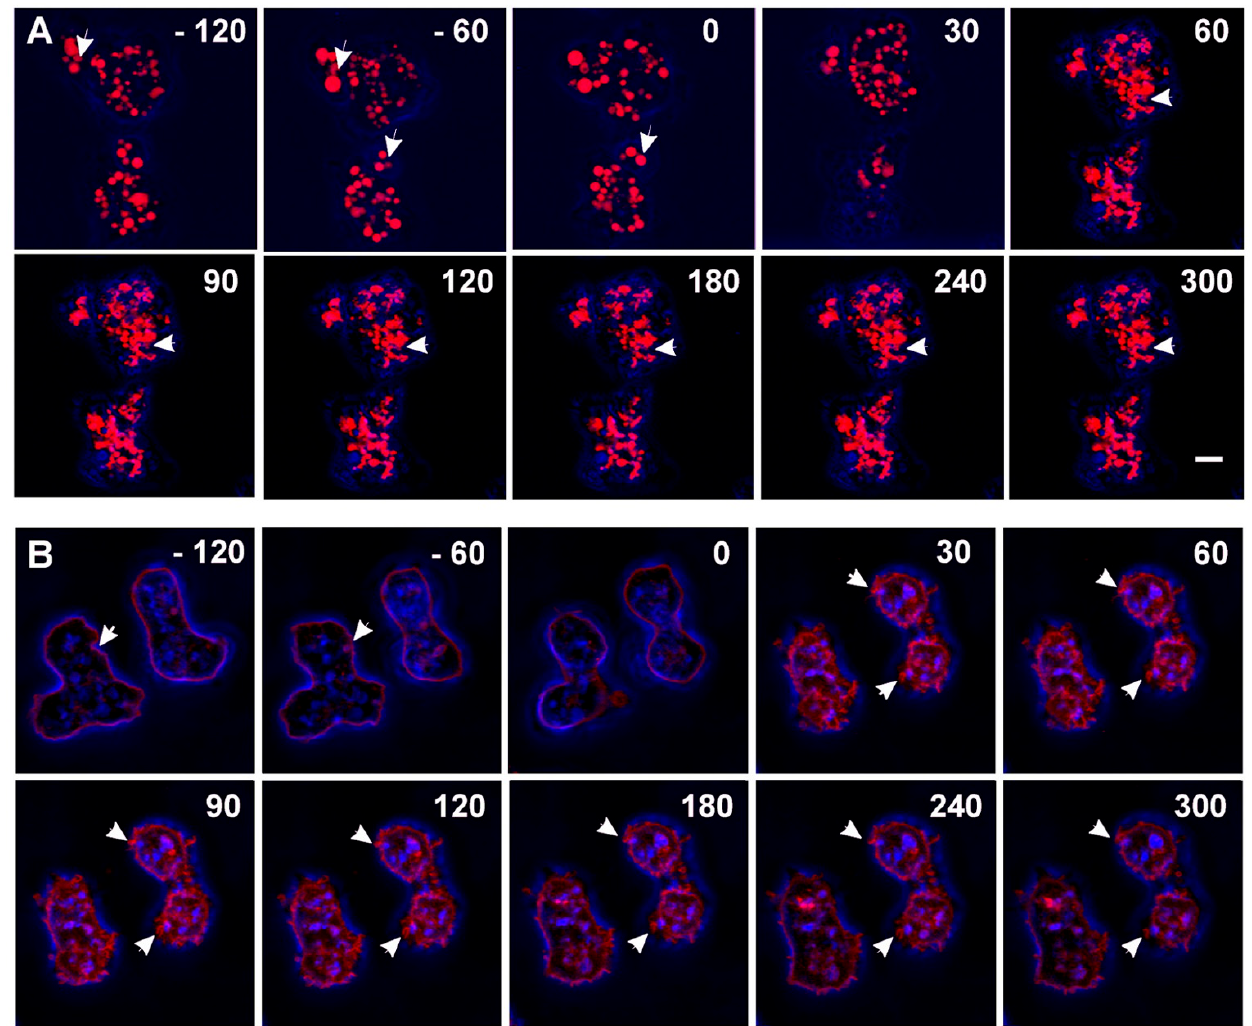
Figure 5 Vesicle mobility and membrane flow are downregulated under hypertonic conditions. Cells were either labeled with TRITC-Dextran (A) or with Cy3.5 (B). Points of time at which confocal images were scanned are indicated in seconds referring to the onset of hyperosmotic shock as T = 0. (A) The fluorescent label of TRITC-Dextran in red is superimposed to phase contrast images in blue. TRITC-Dextran labeled vesicles of cells suspended in SPB buffer are mobile (indicated by arrows in frames -120, -60). Upon sorbitol shock, perturbation and immobilization of vesicles was observed. As an example, a region with stalled and distorted vesicles is indicated by arrows in frames 60-300. (B) The fluorescent label of Cy3.5 in red is superim- posed to phase contrast images in blue. Cells suspended in SPB buffer occassionally endocytose membrane (arrows in frames - 120, -60). Upon hyperosmotic shock, the plasma membrane thickens and forms spikes after cell shrinkage. The spikes are not endocytosed but remain fixed. Typical spikes are indicated with arrows in frames 30-300. Bar = 2 µ